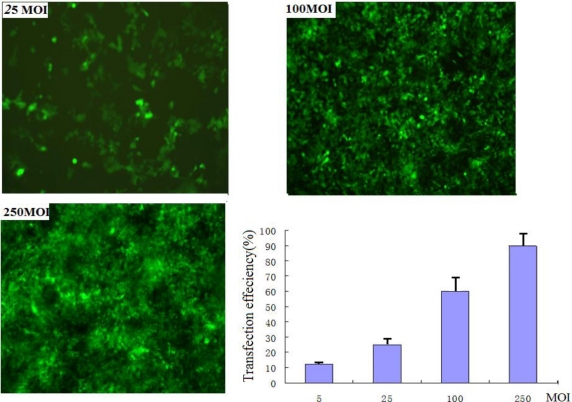
EGFP expression detection by fluorescence microscope. Images of EGFP-expressing cells at 25 MOI (top left), 100 MOI (top right), 250 MOI (bottom left), and plot of transfection efficiencies: the infection efficiencies at the following MOIs: 250, 100, 25 and 5 for 48 hours were 86%, 75%, 26% and 18%respectively.